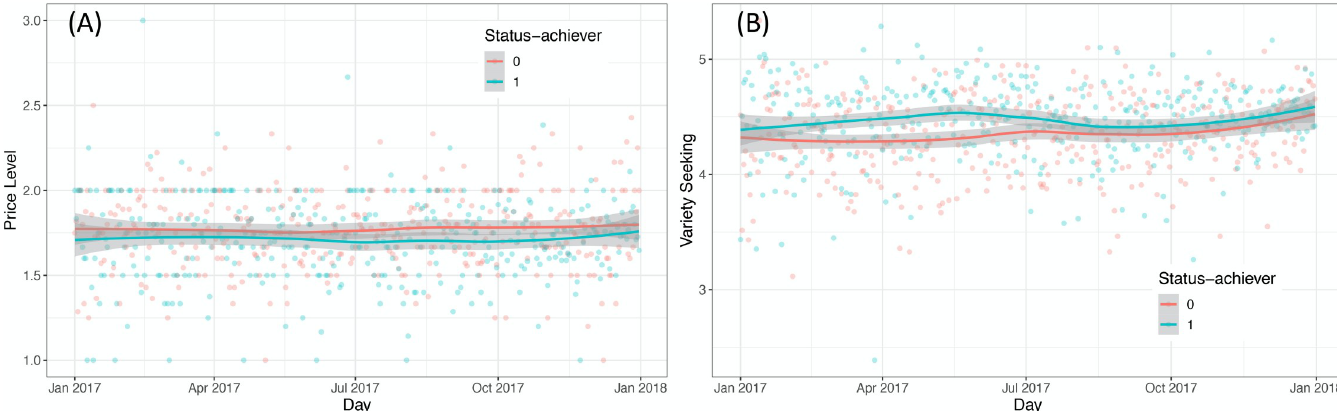
Fig 2. Pre-treatment trends of average price level and variety seeking between status-achievers and non-achievers. The daily average price level (A) and the display of variety seeking (B) between status-achievers and non-achievers before achieving statue in 2017 (during the pretreatment period). There is no obvious difference in the trends of two restaurant choices in the pretreatment period as is displayed above. This supports the parallel pretreatment trend assumption.